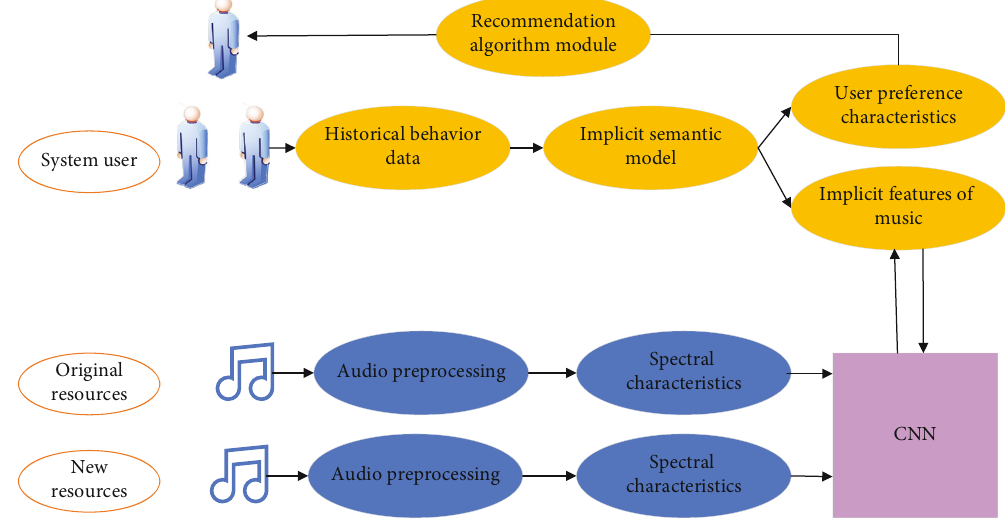
Figure 2: Overall design block diagram of music recommendation system based on